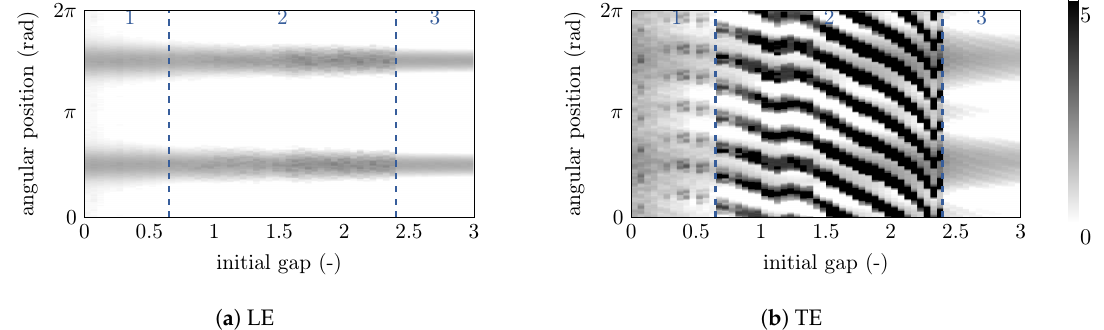
Figure 27. Evolution of the wear profile with the initial clearance for the LP compressor blade.